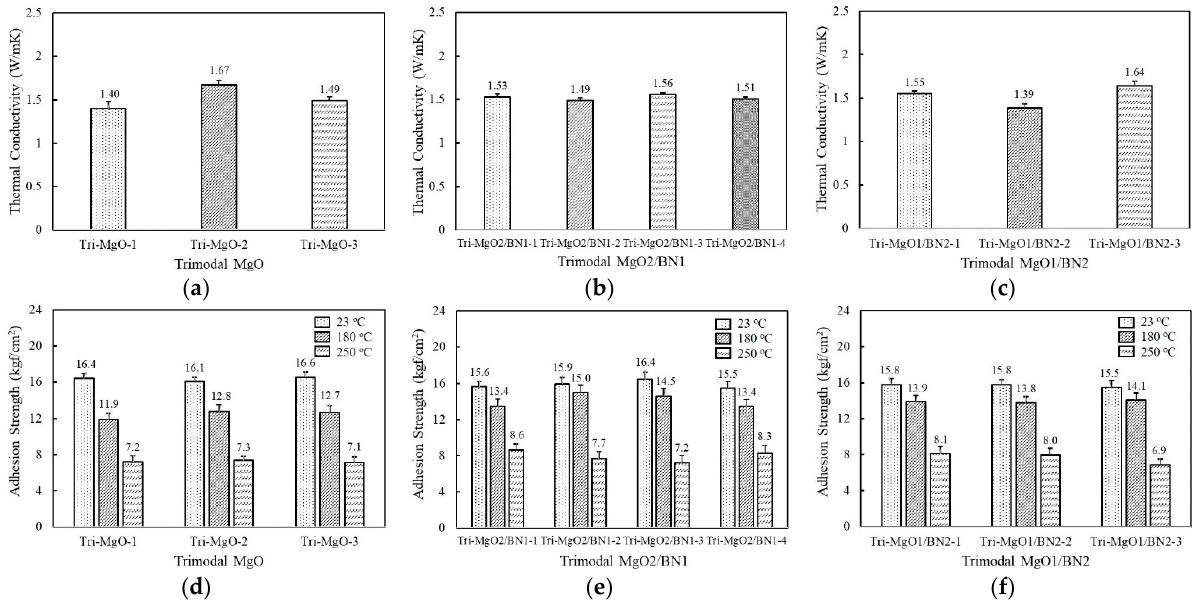
Figure 5. Thethe rmal conductivity and adhesion strength of fluorosilicone adhesives containing three ‐ component MgO and BN fillers: ( a ) thermal conductivity of trimodal MgO; ( b ) thermal conductivity of trimodal MgO2/BN1; ( c ) thermal conductivity of trimodal MgO1/BN2; ( d ) adhesion strength of trimodal MgO at 23 °C, 180 °C, 250 °C; ( e ) adhesion strength of trimodal MgO2/BN1 at 23 °C, 180 °C, 250 °C; ( f ) adhesion strength of trimodal MgO1/BN2 at 23 °C, 180 °C, nad250 °C.